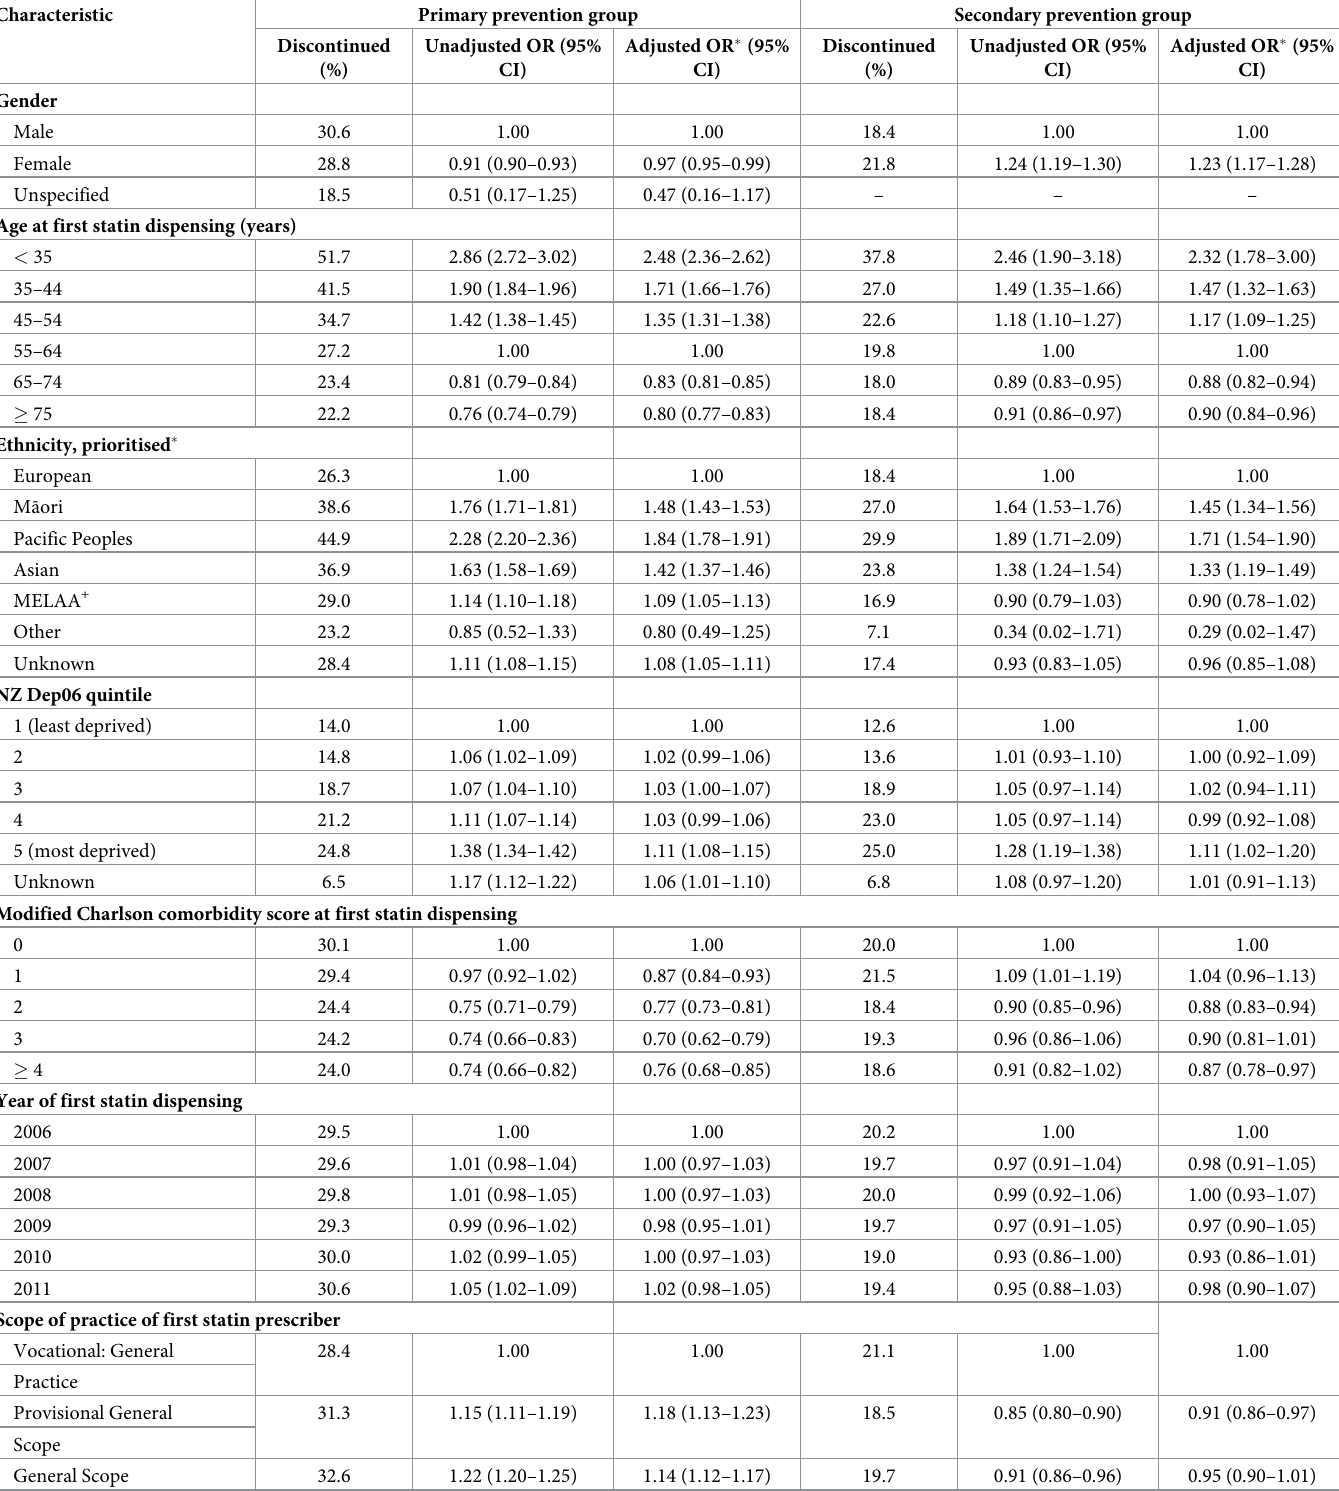
Table 4. Discontinuation in primary and secondary prevention groups in first year of follow–up, by patient characteristics.